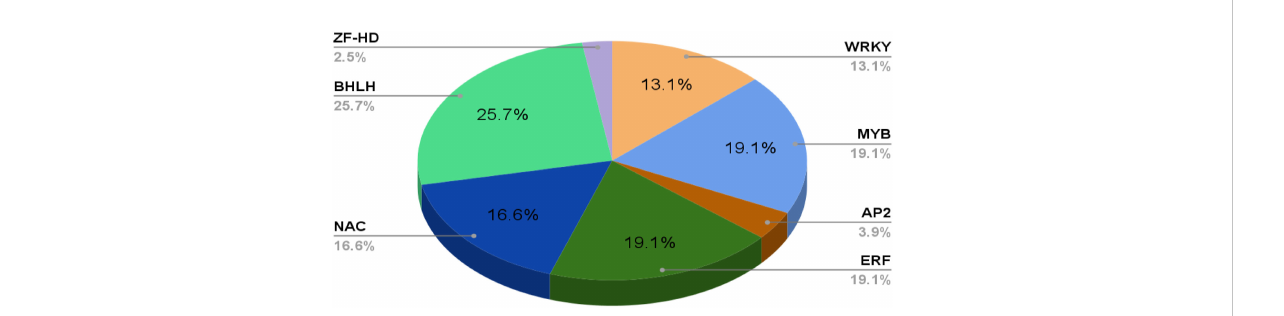
FIGURE 2 Schematic representation of the general pathways leading to various pathways of secondary metabolites biosynthesis such as phenols, terpenoids and N- containing secondary meabolites. PEP: Phosphoenol pyruvate, DMAPP : Dimethylallyl pyrophosphate, GPP: Geranyl pyrophosphate, FPP: Farnesyl pyrophosphate, GGPP: Geranylgeranyl diphosphate PAL : Phenylalanine ammonia-lyase,